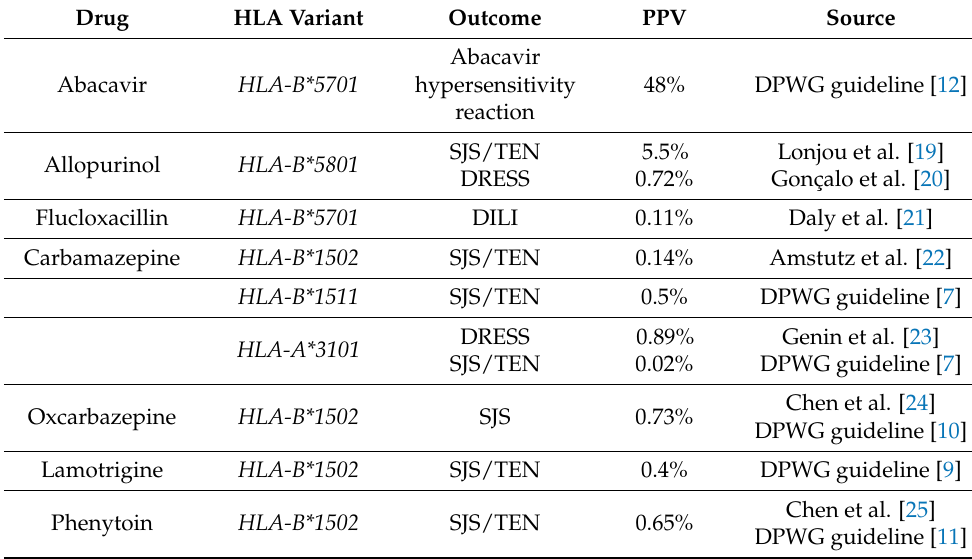
Table 3. Positive predictive values of HLA-drug hypersensitivity